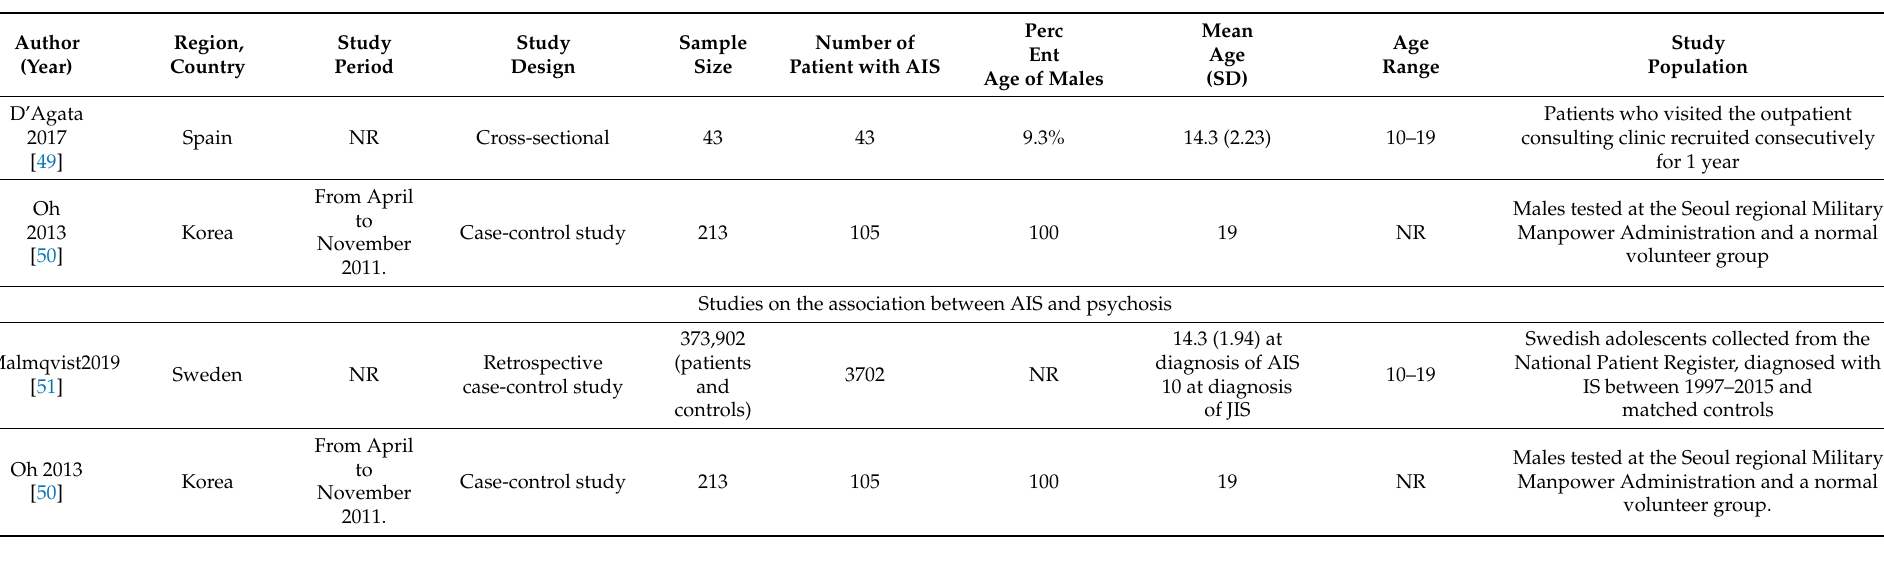
Table 2. Main Findings of the included